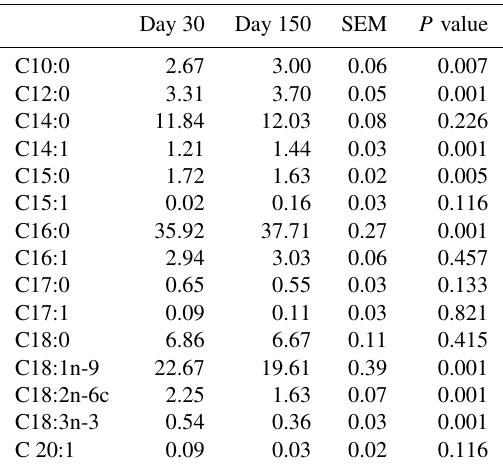
Table 4. Fatty acid composition (%) of milk around days 30 and 150 of lactation in Holstein cows.